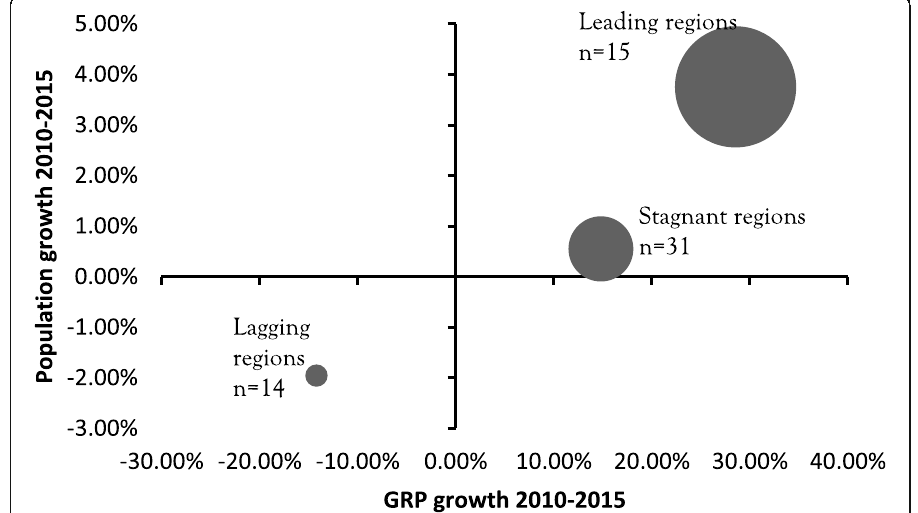
Fig. 4 FA-region groups (mean values) by growth trajectory (2010-2015), bubbles scaled to reflect total sum of GRP in